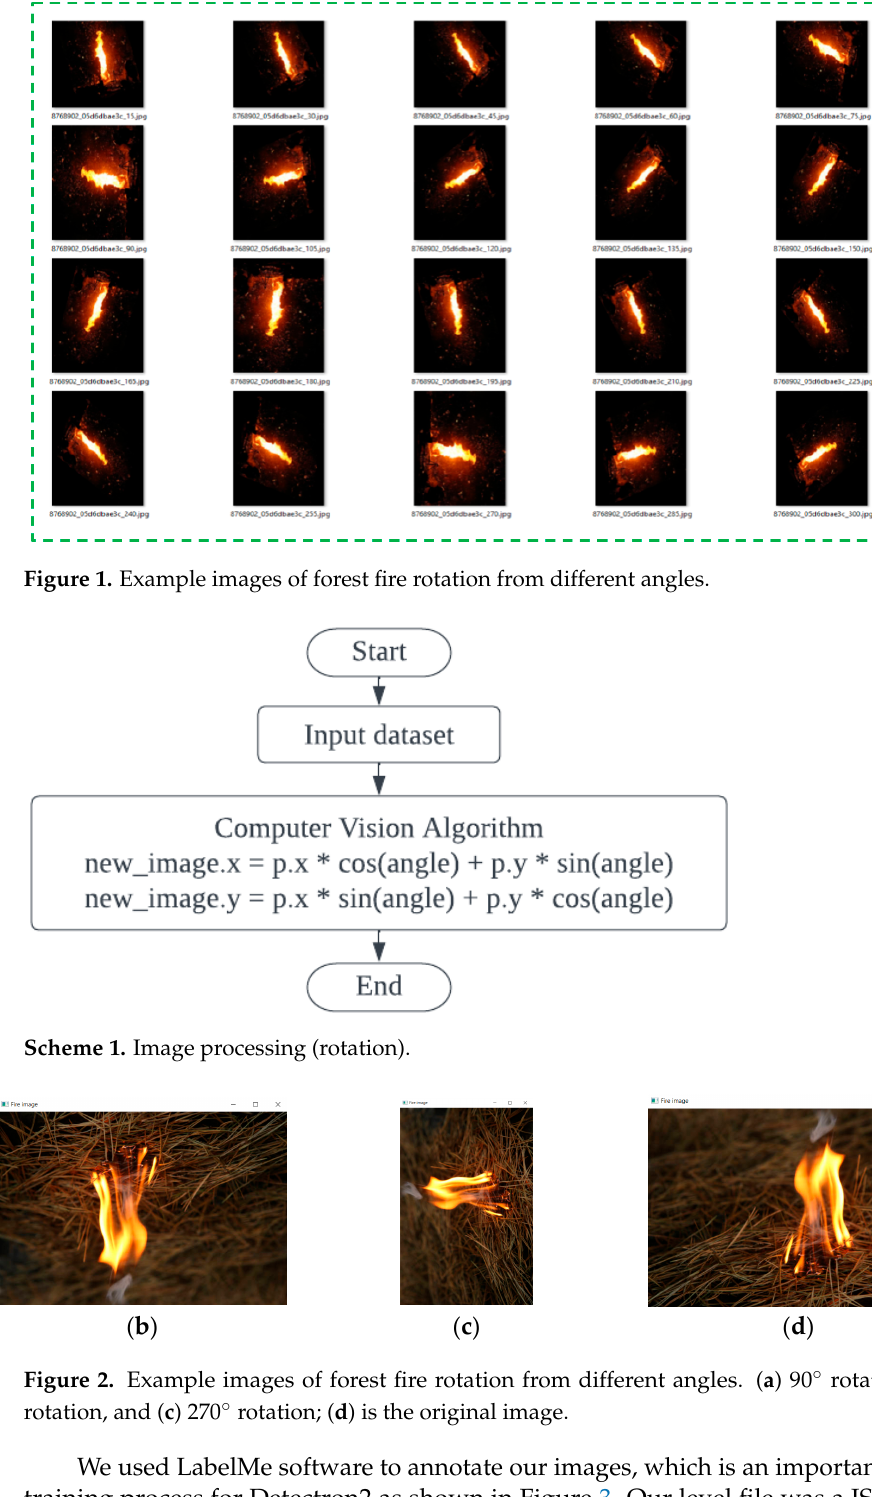
Table 1. The custom dataset of the forest fires.